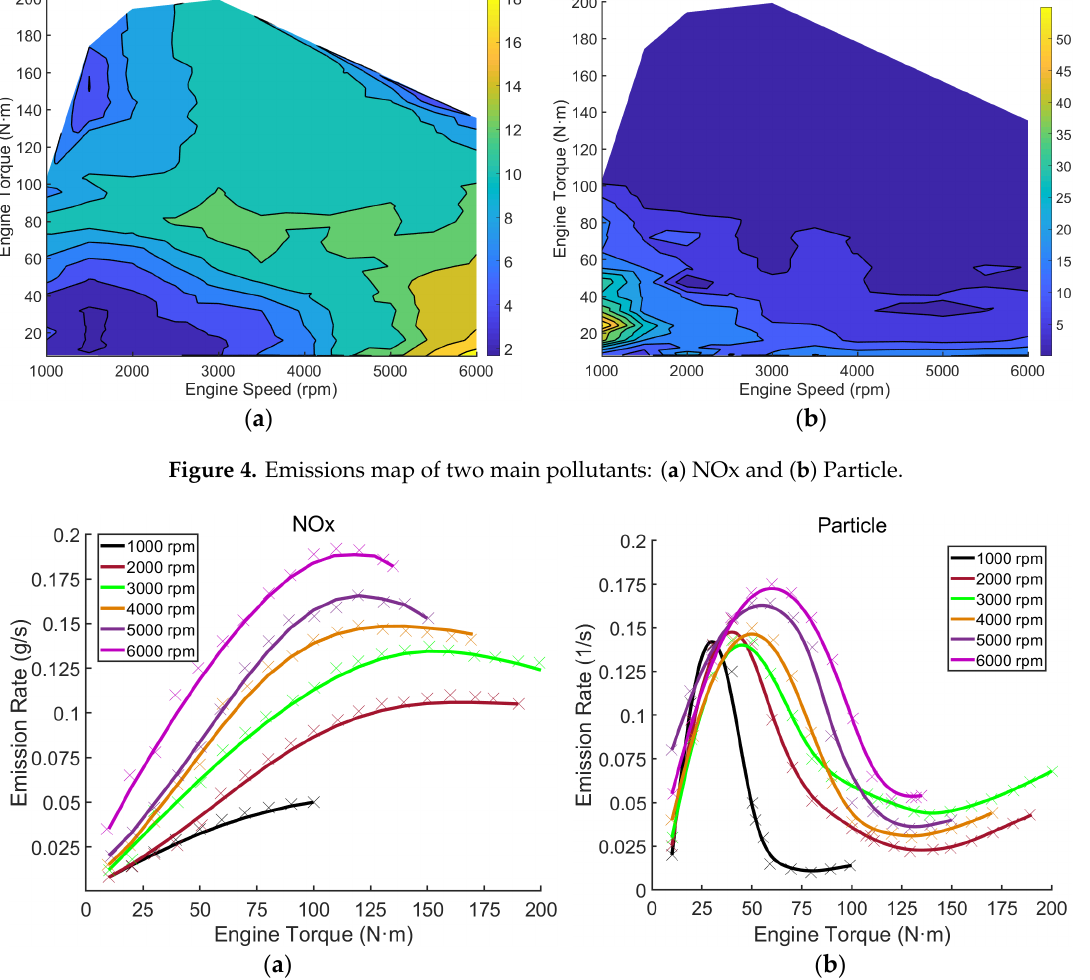
Figure 4. Emissions map of two main pollutants: ( a ) NOx and ( b ) Particle.